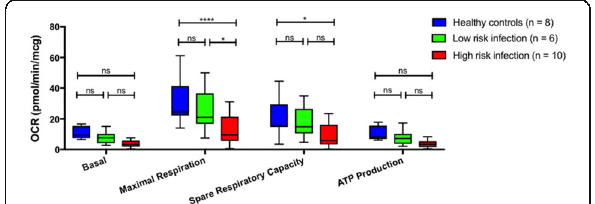
Fig. 1 (abstract P49). Seahorse assay parameters in healthy controls, low and high risk infection groups, measured in oxygen consumption rate (OCR). OCR represents cellular metabolism through mitochondrial respiration. Basal denotes baseline energetic demand of the cell; maximal respiration shows the maximum rate of respiration the cell can achieve; spare respiratory capacity denotes the capability of the cell to respond to energetic demand; ATP production shows ATP produced by the mitochondria to meet the cellular energetic need. p value (2-way ANOVA): ns >0.05, *0.01-0.05, ****<0.0001. Notably, this reduced mitochondrial respiration was not